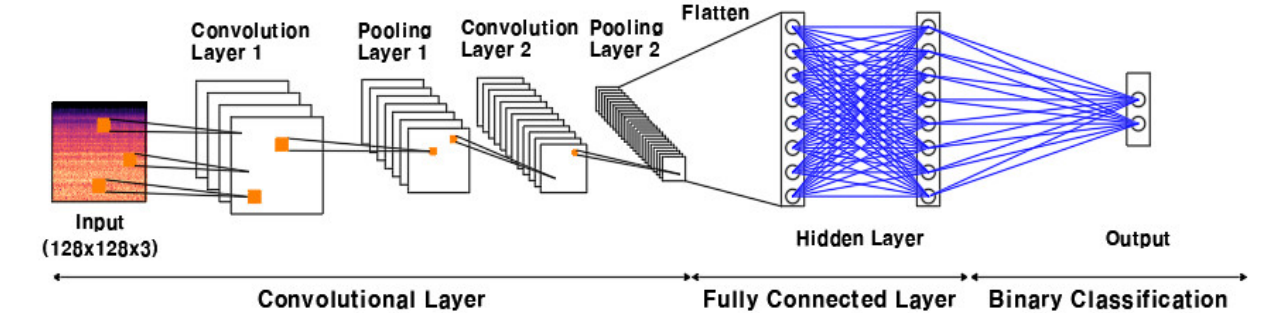
Figure 1. Structure of convolutional neural networks (CNNs).